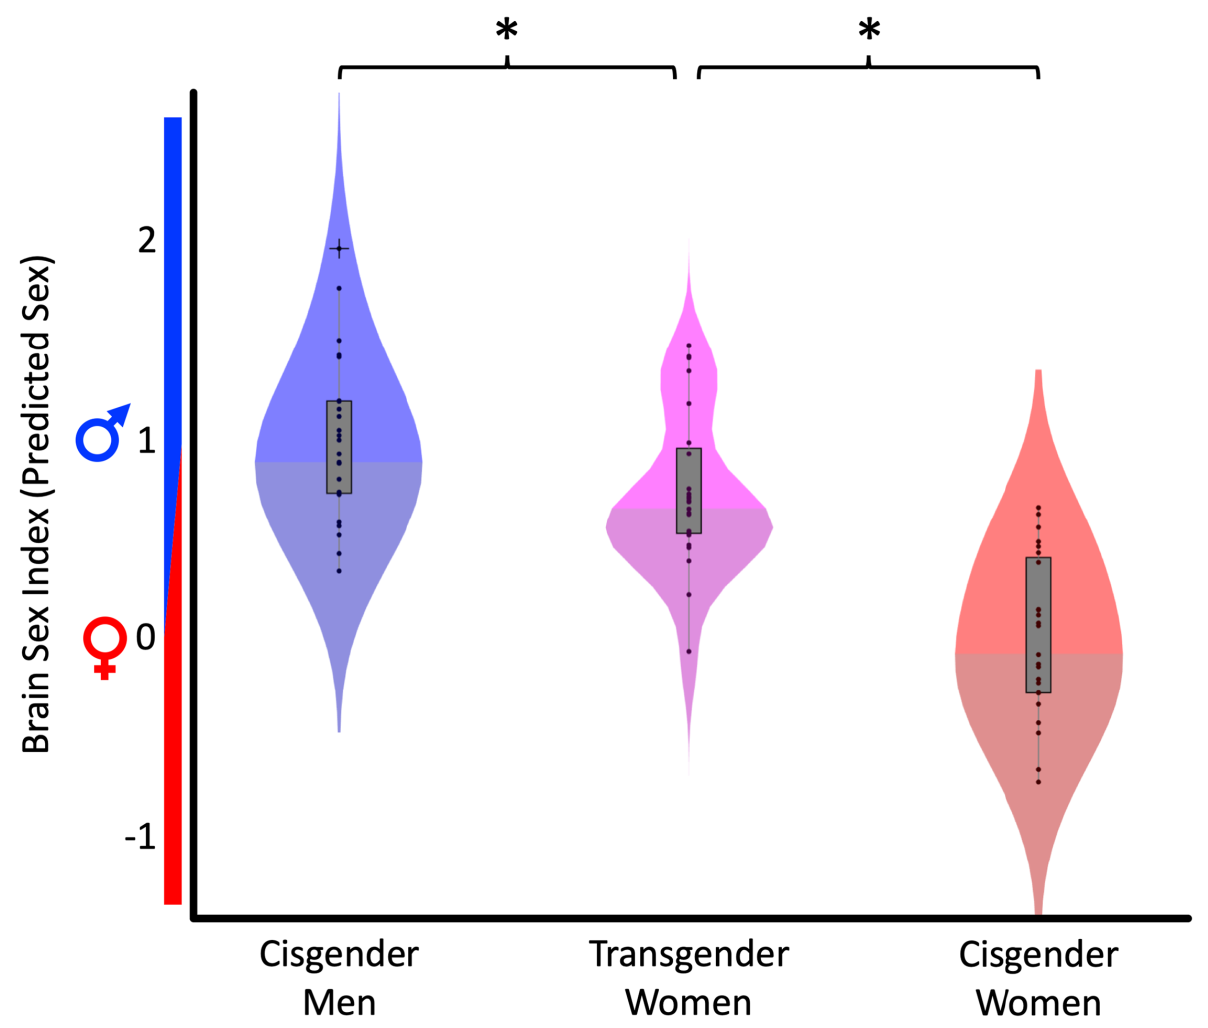
Figure 1. Significant Group Differences in estimated Brain Sex. The x-axis refers to the three groups. The y-axis displays the estimated Brain Sex (0 = average female; 1 = average male). Data are displayed as violin plots for cisgender men (blue), transgender women (pink), and cisgender women (red). The gray center of each violin contains the values between the 25th and 75th percentiles, the 24 black oval markers correspond to the 24 brains in each group, and the ‘+’ marks a brain that is outside the 1.5 interquartile range (vertical gray lines). The asterisks indicate significant group differences.